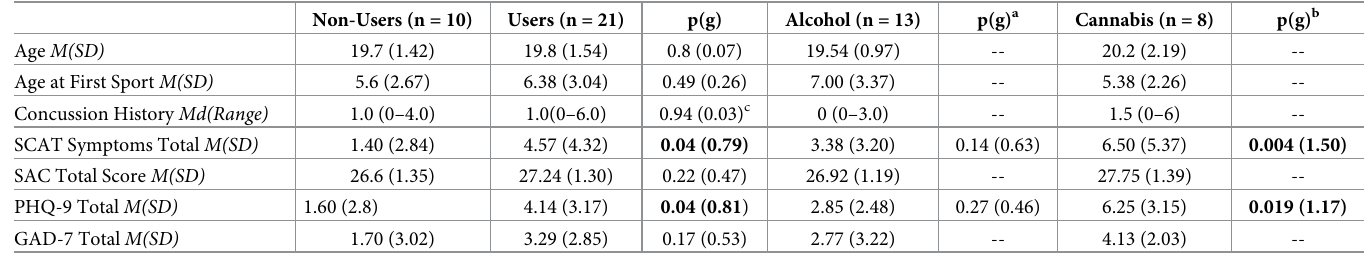
Table 1. Participant characteristics.